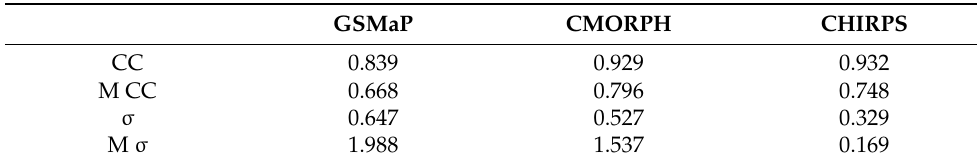
Table 4. Medians for the values at each pixel across the study area. M CC and M σ refer to the TCA metrics when the multiplicative error model was used.